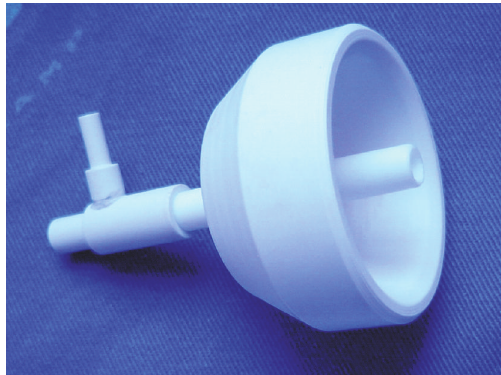
Figure 1: Actual urethral device used in the noninvasive